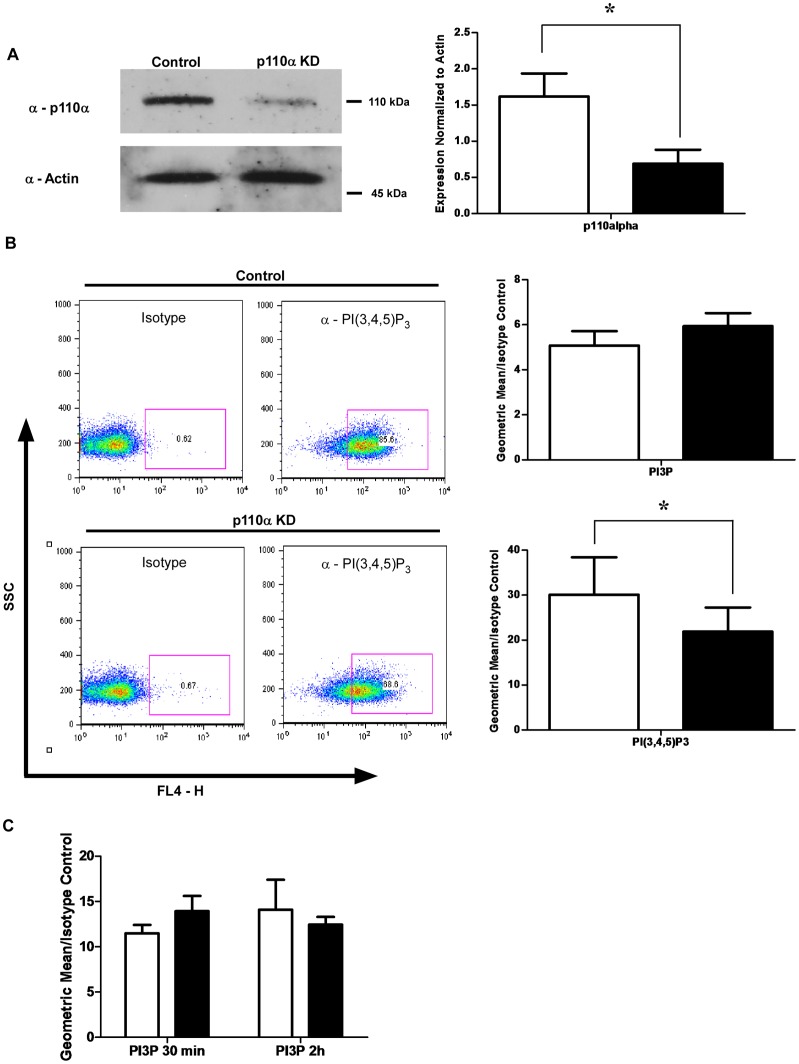
Phagosomes contain the class IA PI3K p110α, and display PI(3,4,5)P3.Phagosomes from p110αknockdown cells show decreased p110α recruitment and PI(3,4,5)3 levels. A)
Phagosomes isolated from PMA-differentiated THP-1 cells contain the class IA PI3K p110α, and this is decreased in knockdown cells. Late stage 4 h bead phagosomes were isolated by magnetic pulldown, lysed, and immunoblotted for p110α. Actin was done as a loading control. Densitometry of four independent experiments indicates a significant decrease in phagosomal p110α in phagosomes isolated from knockdown cells. Empty bars  =  control cell phagosomes, solid bars  =  phagosomes from p110α knockdown cells. p<0.05 B)
Phagosomes from p110α knockdown cells contain less PI(3,4,5)P3, but similar amounts of PI3P as control cells. Bead phagosomes were isolated by magnetic pulldown, fixed, stained for PI3P and PI(3,4,5)P3, and flow organellometry was done. A representative dot plot of SSC vs FL4 fluorescence channel depicting how the phagosomes were gated is shown. The data shows PI(3,4,5)P3 staining of 4 h phagosomes isolated from control and p110α knockdown cells from one experiment. Empty bars  =  control cell phagosomes, solid bars  =  phagosomes from p110α knockdown cells Data are means +/− s.e.m., from four independent experiments. The levels of PI(3,4,5)P3 were found to be significantly decreased in phagosomes isolated from p110α deficient cells. p<0.05. No significant differences were observed for PI3P levels. C)
Kinetics of PI3P acquisition onto phagosomes. Phagosomes were isolated at 30 min and 2 h and stained for PI3P. The graph shows geometric means normalized to isotype control. Open bars  =  phagosomes isolated from control cells, Solid bars  =  phagosomes isolated from p110α knockdown cells. No significant differences were observed, and PI3P levels appeared to remain consistent throughout phagosome maturation.